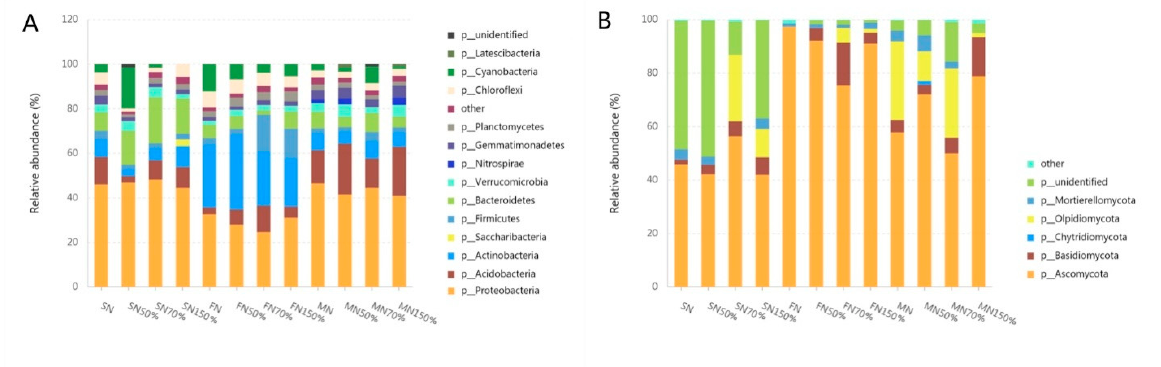
Figure 3. Analysis of difference in colony structure of each sample at phylum level. ( A ): Bacteria; ( B ): Fungi. Table 1. Analysis of the significance of differences between dominant phyla treatments in the rhizosphere samples of oilseed rape at seedling, flowering and mature stages.